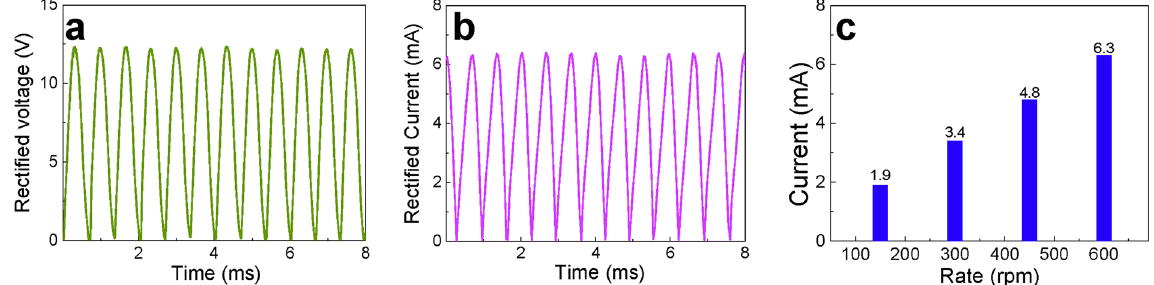
Figure 4. ( a ) Output voltage and ( b ) current of the TENGs. ( c ) Dependence of the amplitude of the output short circuit current on the rotation rate of the TENGs.